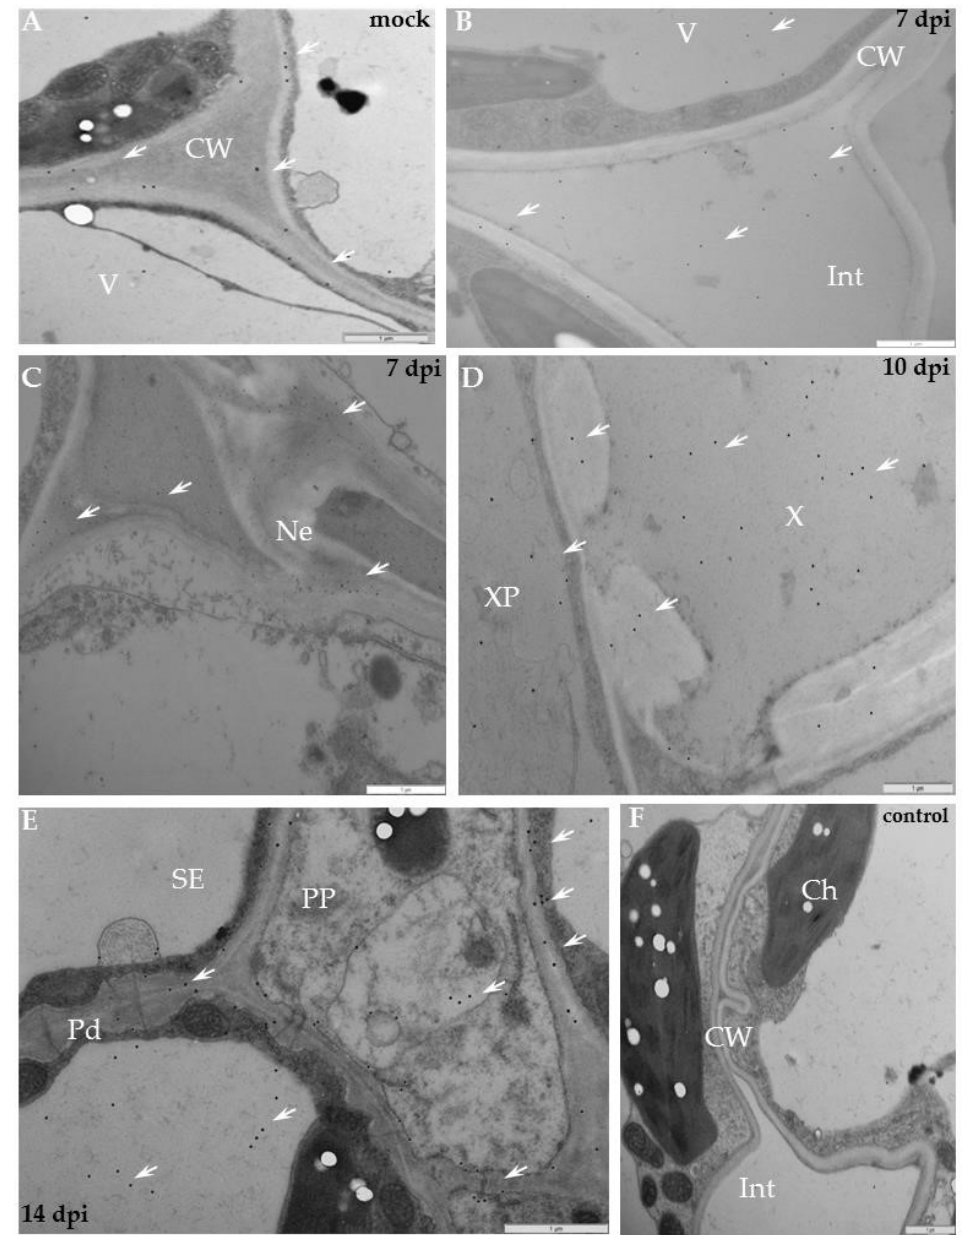
Figure 10. Immunogold labeling of xyloglucan xyloglucosyl-transferase (XTH-Xet5) after potato–PVY NTN incompatible interaction. ( A ) Gold granules of XTH-Xet5 depositions (arrows) in cell wall and in vacuoles of mock-inoculated S á rpo Mira plant. Bar 1 µ m. ( B ) Gold granules of XTH-Xet5 deposition (arrows) present in cell wall, intercellular space, cytoplasm and in vacuole seven days post-inoculation. Bar 1 µ m. ( C ) XTH-Xet5 localisation (arrows) in cell wall and in necrotised area seven days post-inoculation. Bar 1 µ m. ( D ) Deposition (arrow) present in xylem tracheary element and in xylem parenchyma cell 10 days post-PVY inoculation. Bar 1 µ m. ( E ) XTH-Xet5 deposition (arrows) in cell wall, vesicular/membranous structures and in plasmodesmata rounded areas in phloem, 14 days post-inoculation. Bar 1 µ m. ( F ) Lack of gold depositions in potato S á rpo Mira–PVY NTN compatible interaction when primary antibodies were omitted (control). Bar 1 µ m. Ch—chloroplast, CW—cell wall, Int—intercellular space, Ne—necrosis, Pd—plasmodesmata, PP—phloem parenchyma, SE—sieve element, V—vacuole, X—xylem, XP—xylem